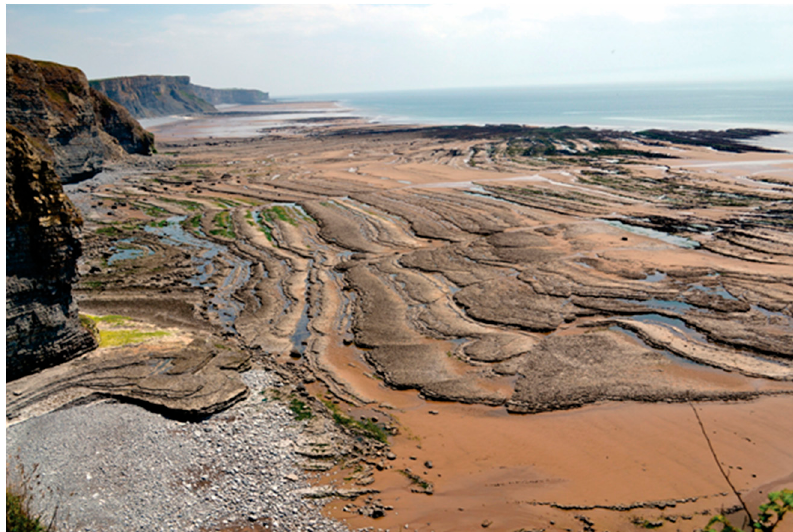
Figure 1. Cliff and intertidal shore platform in Liassic limestones and shales in the Vale of Glamorgan, southern Wales, UK. Pertinent questions might concern the: age of this coast and whether it is partly inherited; nature and efficacy of the formative processes; role of geological conditions; morphodynamics of the pebble and sand platform-beach; and past and potentially future impact of changes in climate and sea level.